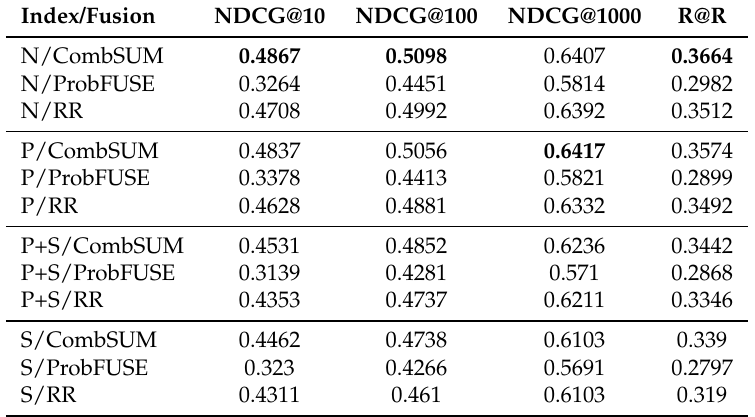
Table 14. T2: NDCG and Recall@R for the fusion runs with QE+RF. The highest values are in